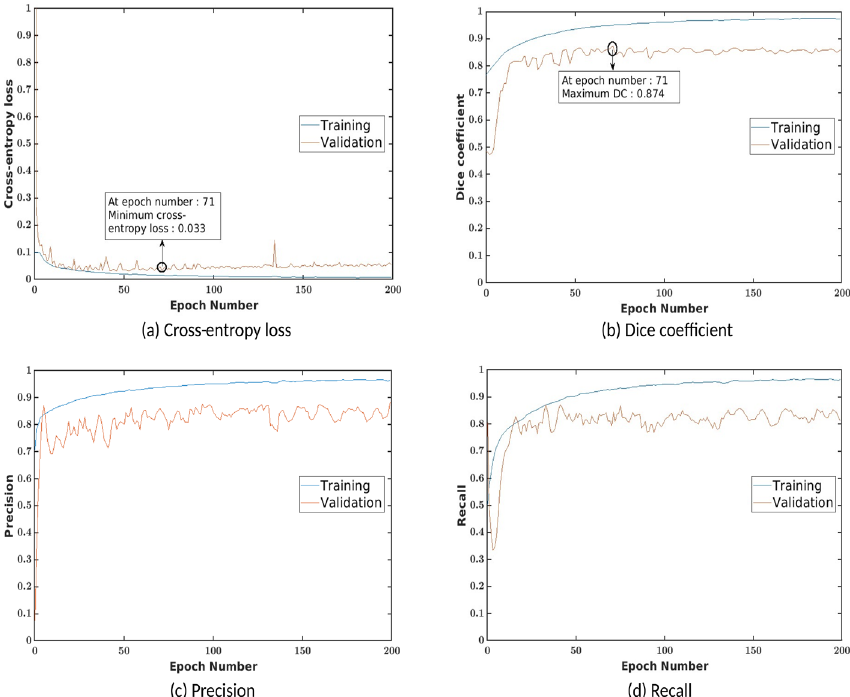
Figure 4. Training and validation performance of the faRIA:256 model over 200 epochs. X- and Y-axes represent the epoch number and performance measure, respectively.